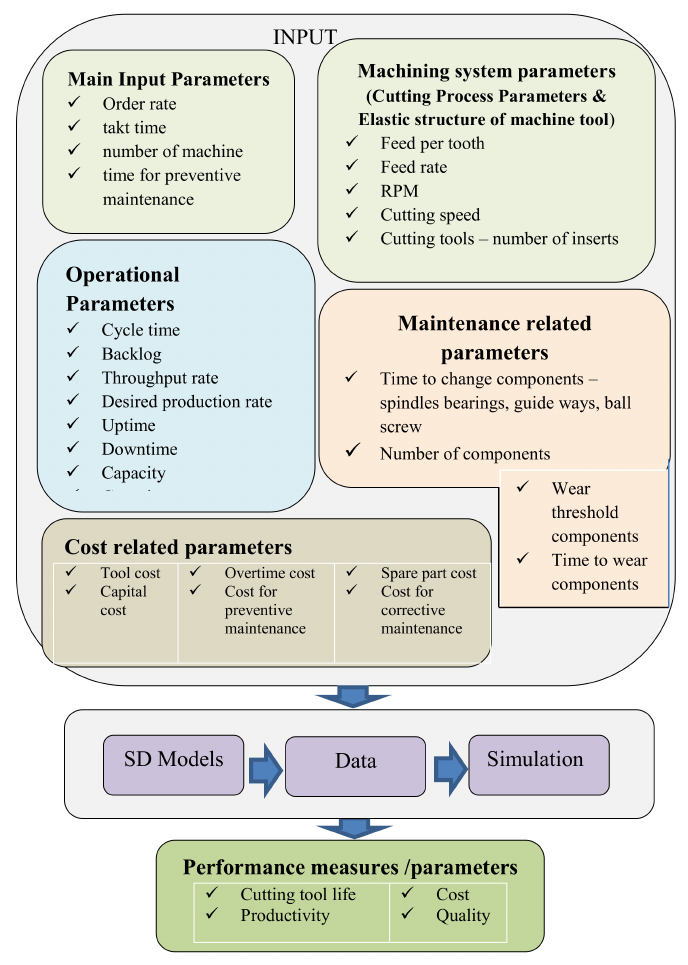
Figure 3. Modelling approach for the machining